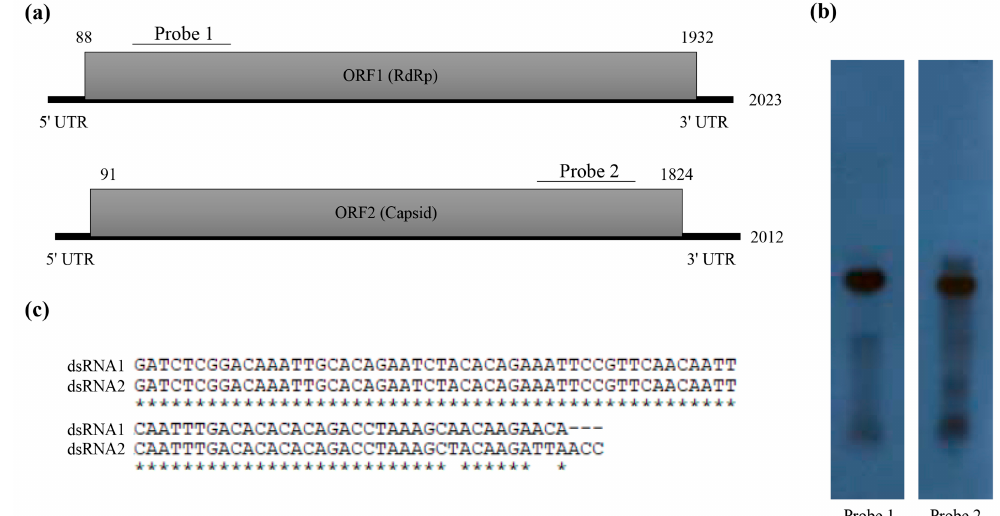
Figure 2. Molecular characteristics of the T. atroviride partitivirus 1 (TaPV1) genomic double-stranded RNAs (dsRNAs). ( a ) Schematic diagrams of the genomic organization of TaPV1 dsRNA segments. Shaded boxes are open reading frames (ORFs) encoding RNA-dependent RNA polymerase (RdRp) and coat protein (CP). Numbers indicate the total lengths of the TaPV1 genome segments and the positions of the start and stop codons. ( b ) Northern blot analysis of TaPV1 dsRNA1 and dsRNA2. RNAs were hybridized with probes for dsRNA1 and dsRNA2, and these probes are indicated in panel ( b ). ( c ) Alignment of the 5’-terminal untranslated regions of dsRNA1 and dsRNA2 of TaPV1. The conserved sequences are indicated with asterisks.